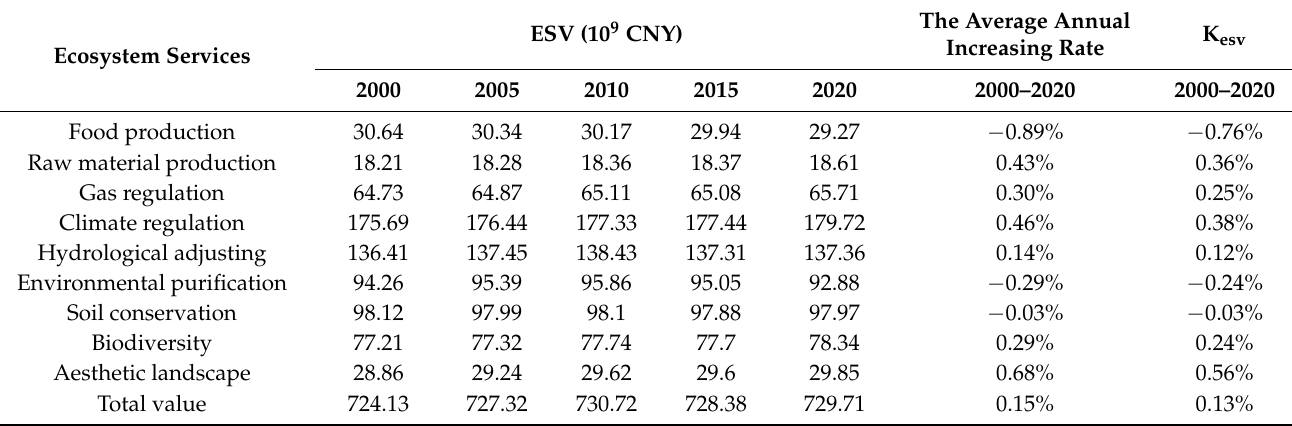
Table 3. Changes in the value of ecological services in Sichuan Province from 2000 to 2020.